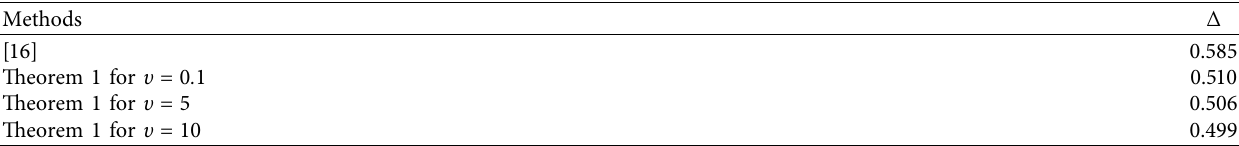
Table 2: Comparison results of ∆ for Example